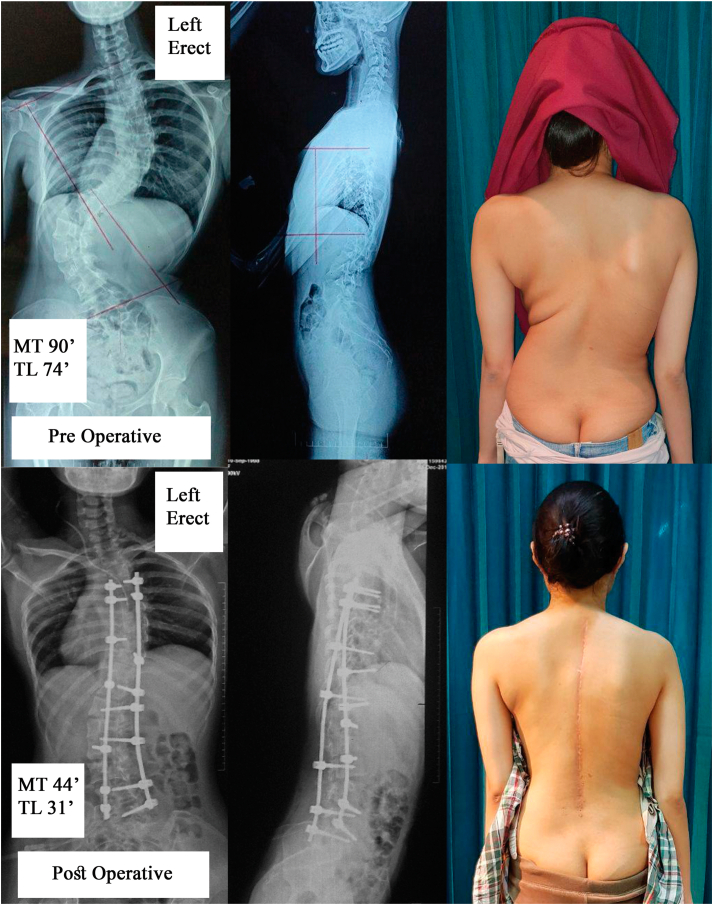
Female18 years old treated with preoperative Cotrel longitudinal traction. Initial Cobb angle was 90°, which was corrected to 44° post operatively.